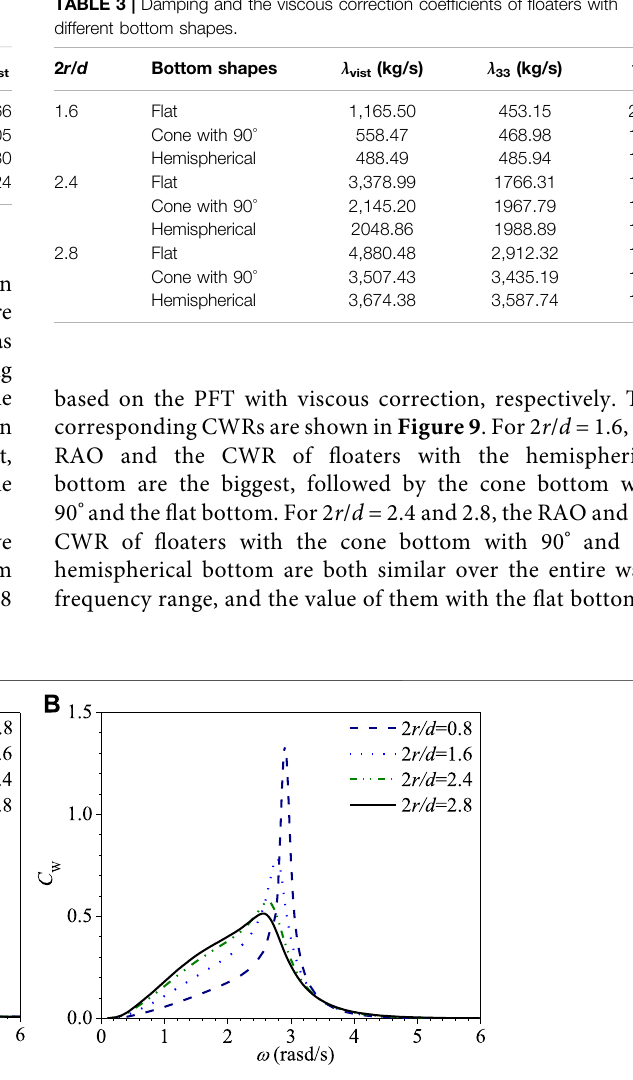
Figure 7 | Variations of heave RAO and CWR C W vs. ω of hemisphere bottom cylindrical WEC with different 2 r / d . (A) RAO. (B) CWR.